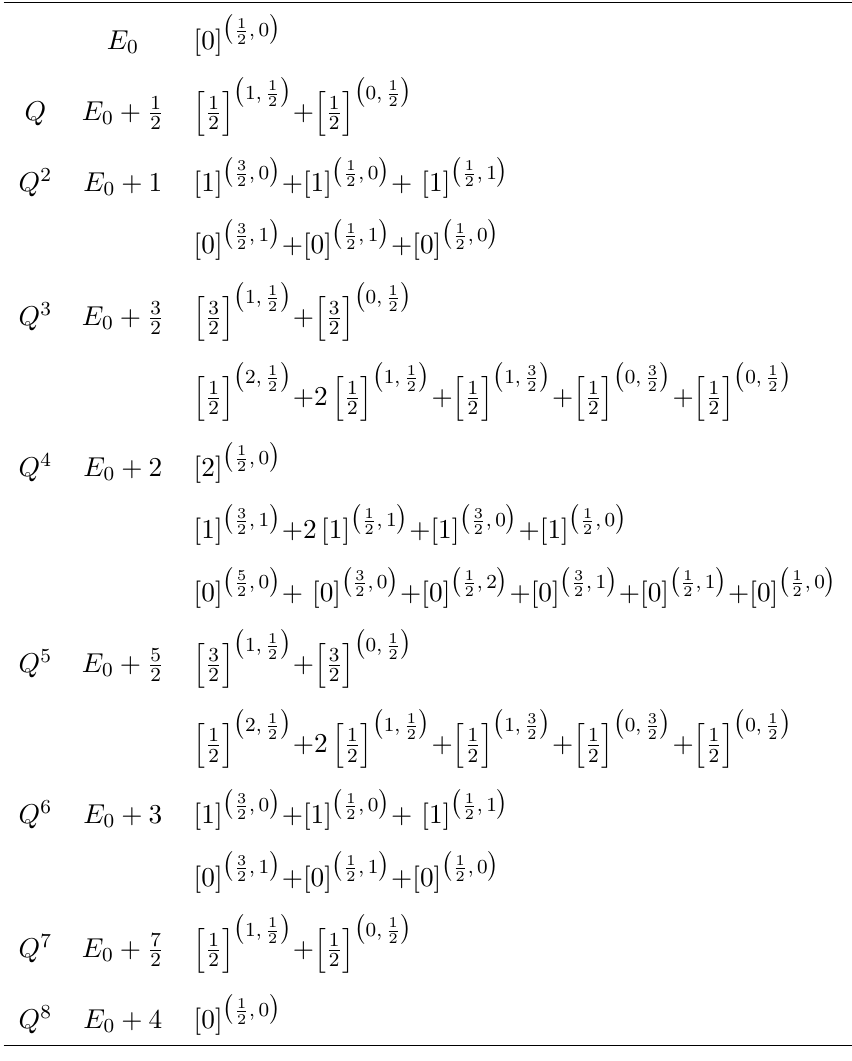
(cid:2) (cid:3) E 0 , 1 , 0 . 2 F